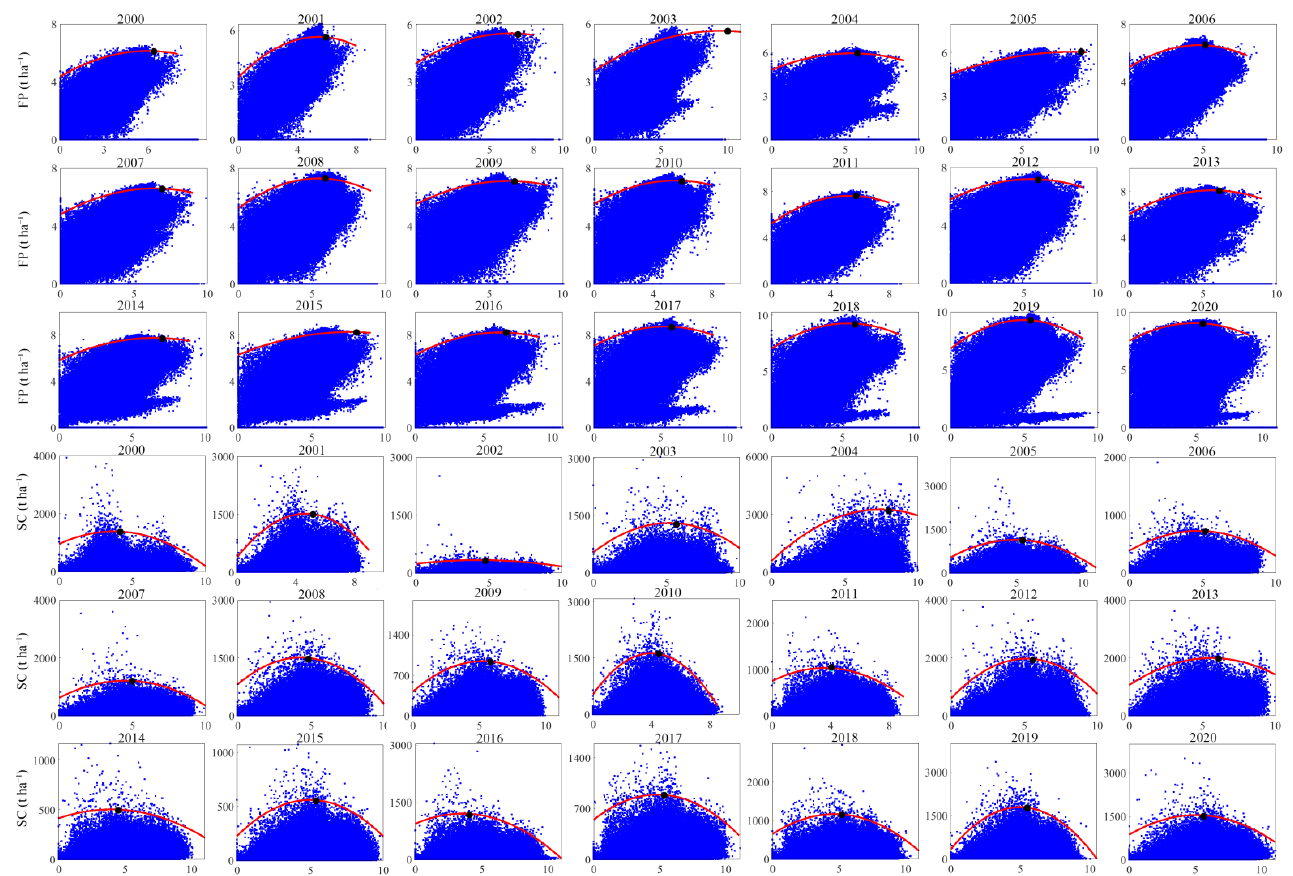
Figure 6. The scatter clouds (blue points), thresholds (black points), and constraint lines (red lines) between paired ESs (A_B) from 2000 to 2020. A indicates the constraint ES on the x -axis and B indicates the corresponding ES on the y -axis. NPP: net primary productivity; FP: food production; SC: soil conservation. The units of NPP, SC and FP are t ha − 1 year − 1 .